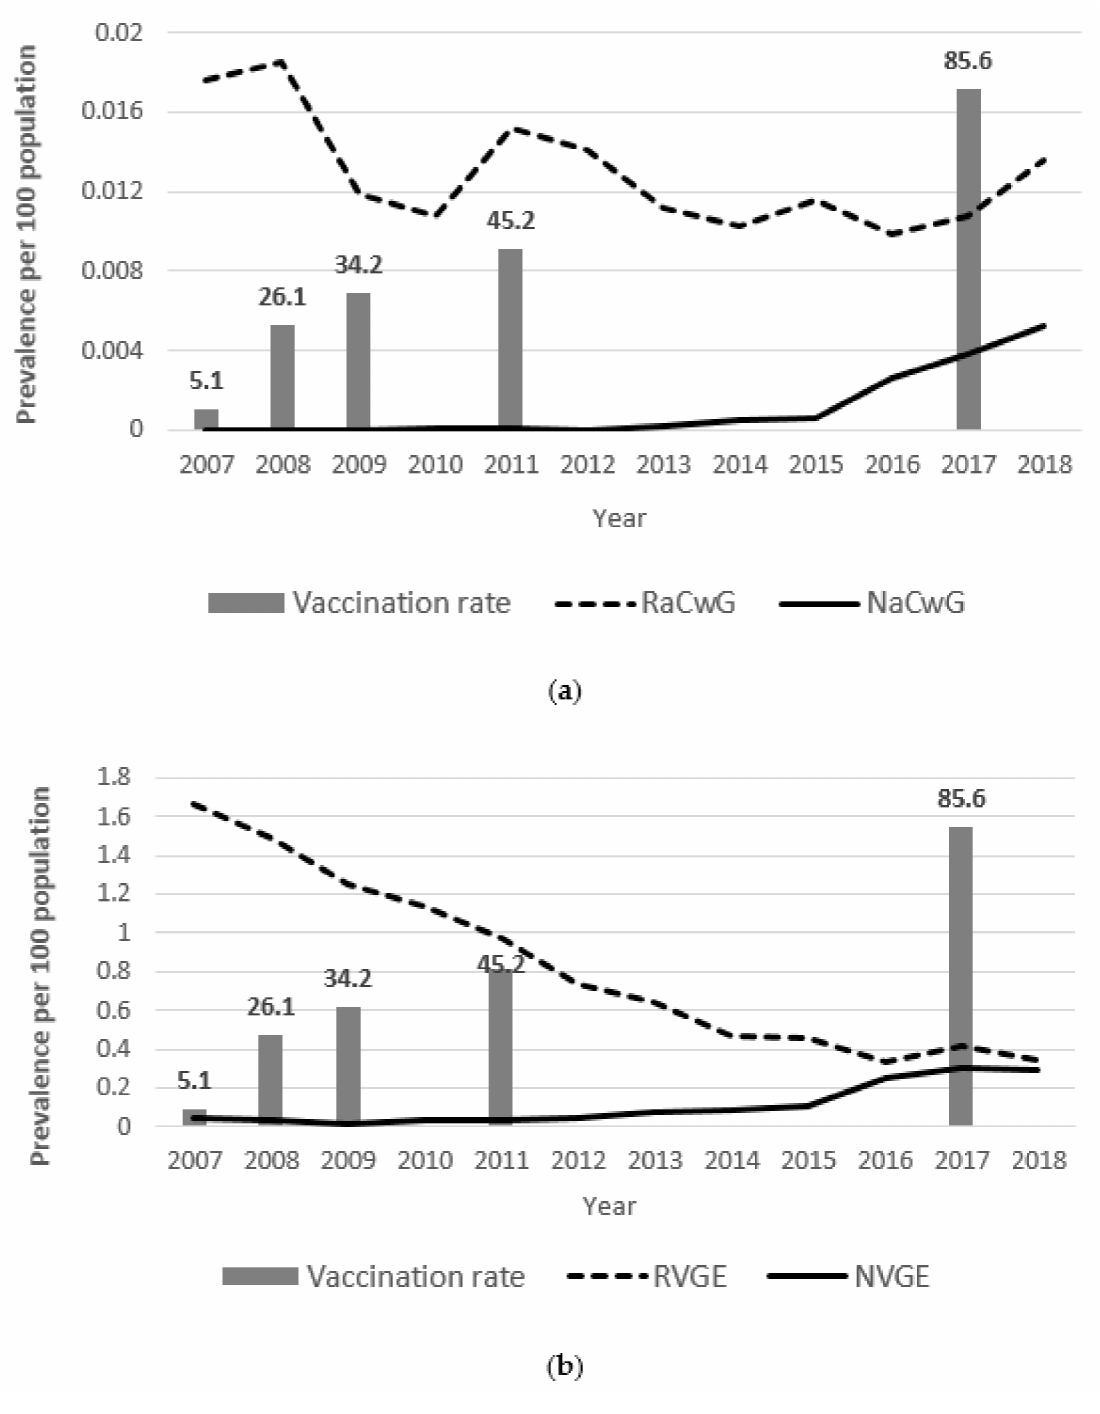
Figure 1. Annual changes of the prevalence of rotavirus gastroenteritis (RVGE), rotavirus-associated benign convulsion with mild gastroenteritis (RaCwG), norovirus gastroenteritis (NVGE) and norovirus gastroenteritis (NaCwG) and the vaccination rate. ( a ) Annual changes of the RaCwG prevalence per 100 comprising the mid-year point (MYP) (Exp(B): 0.956, p = 0.190) and NaCwG patients per 100 comprising the MYP (Exp(B): 1.790, p < 0.001). ( b ) Annual changes of the prevalence of RVGE (Exp(B): 0.869, p < 0.001) and NVGE (Exp(B): 1.224, p < 0.001) per 100 comprising the